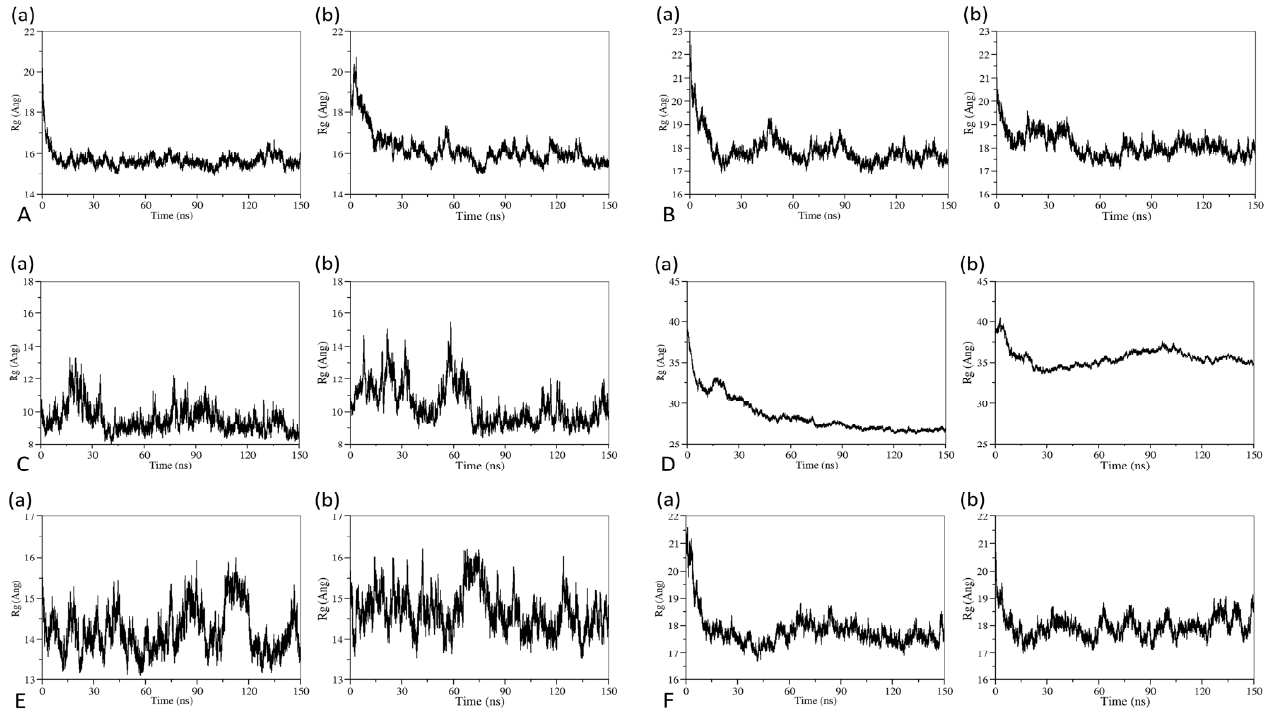
Figure 8. R g evolutions during the simulation time of ( a ) the systems without cosolvents and ( b ) the systems with cosolvents. ( A ) represents the Cyclosporine system, ( B ) represents the Docetaxel system, ( C ) represents the Etoposide system, ( D ) represents the Paclitaxel system, ( E ) represents the Valrubicin system, and ( F ) represents the Cabazitaxel system.